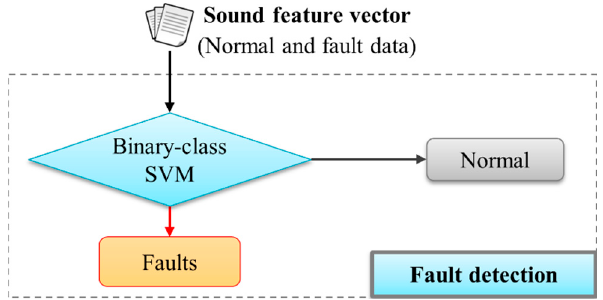
Figure 11. Architecture for fault-sound detection based on a binary SVM.